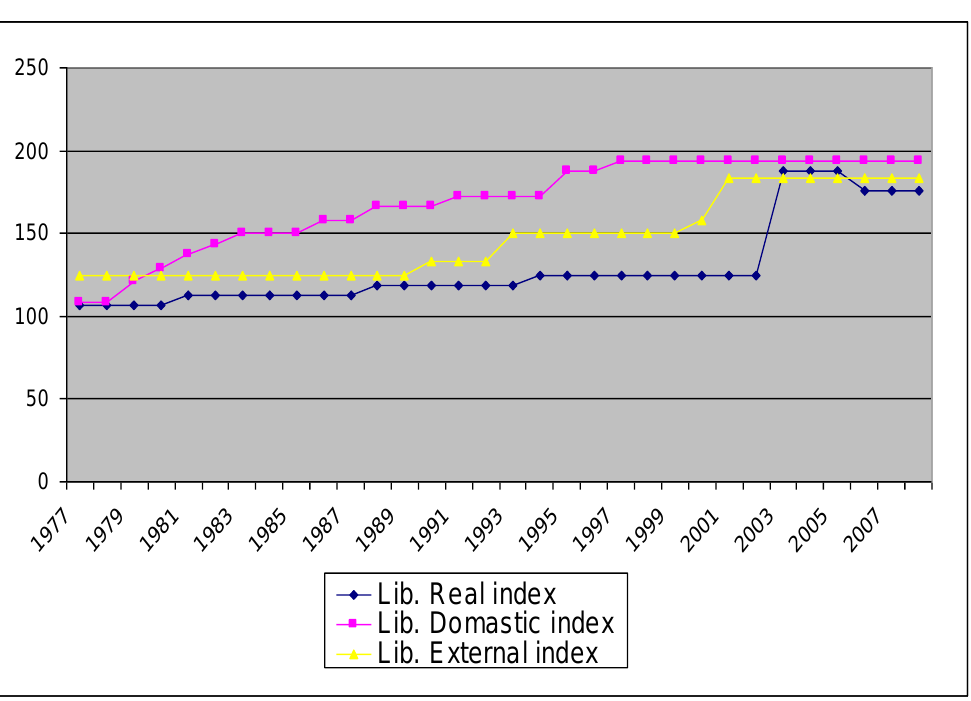
Figure 5: Sri Lankan Liberalization Index - Real Sector /Domestic Sector/ External